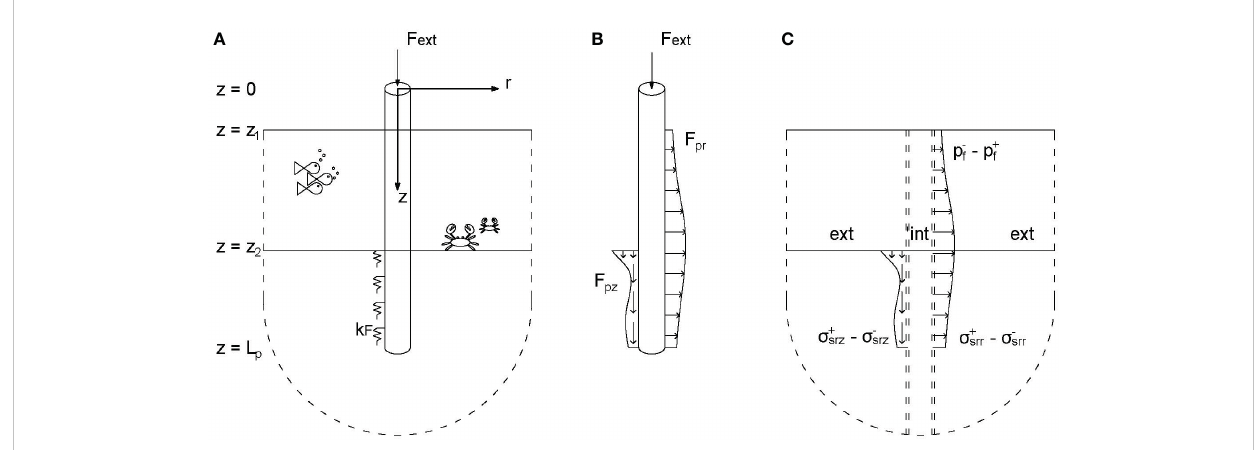
FIGURE 1 The sub-structuring approach of the model: (A) the model geometry, (B) the in-vacuo pile substructure with an external load on top and distributed loads representing the fl uid and soil response, and (C) the internal and external fl uid-soil substructures with the pile load acting on the boundaries at r = r p